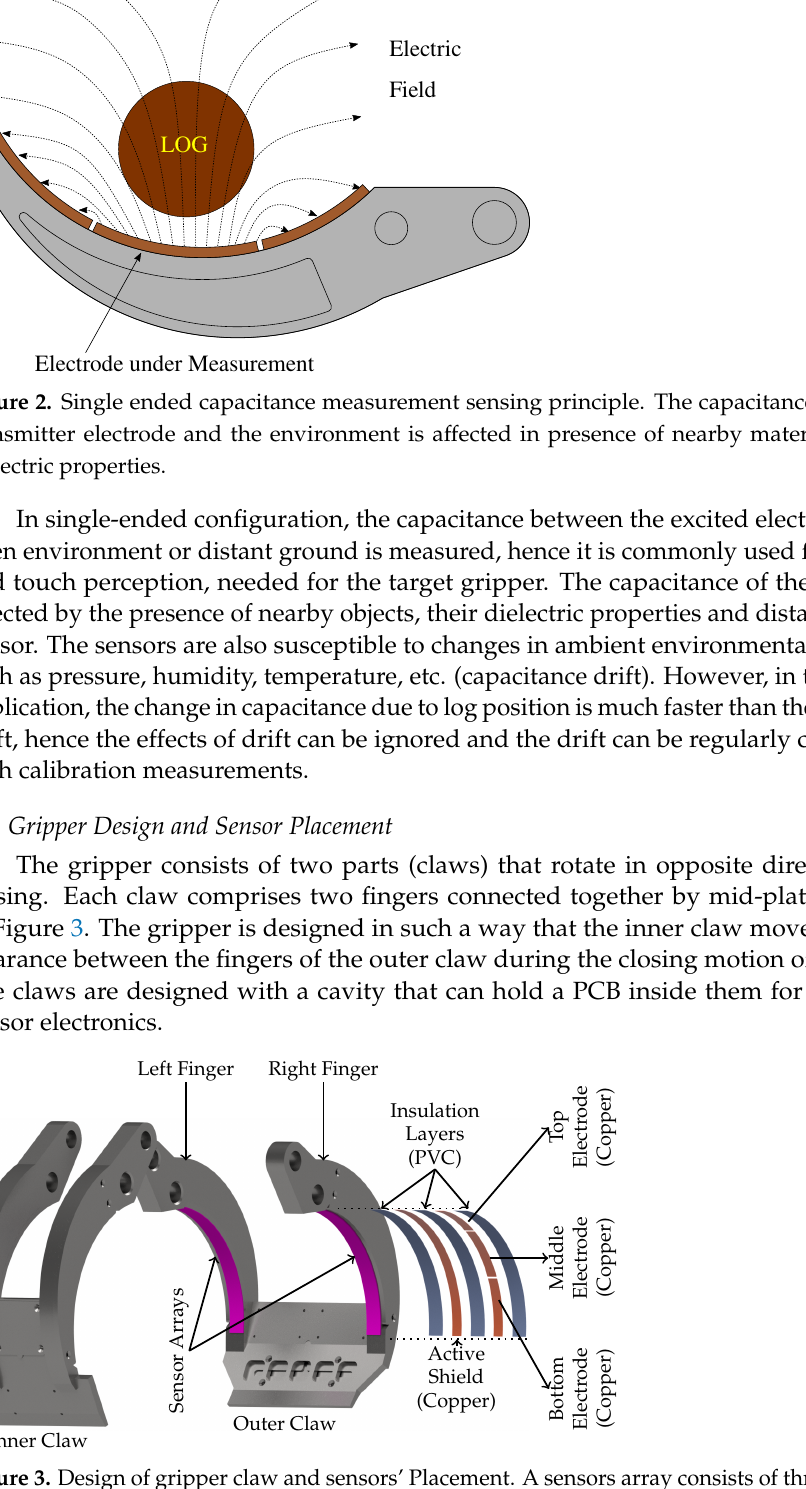
Figure 3. Design of gripper claw and sensors’ Placement. A sensors array consists of three transmitter electrodes (top, middle and bottom) as illustrated in the expanded view. The electrodes are placed over an active shield layer separated by an insulating layer. The electrode/shield layers are then fully enclosed in an insulating enclosure. The sensor arrays are placed each on both the left and right fingers of the the outer gripper